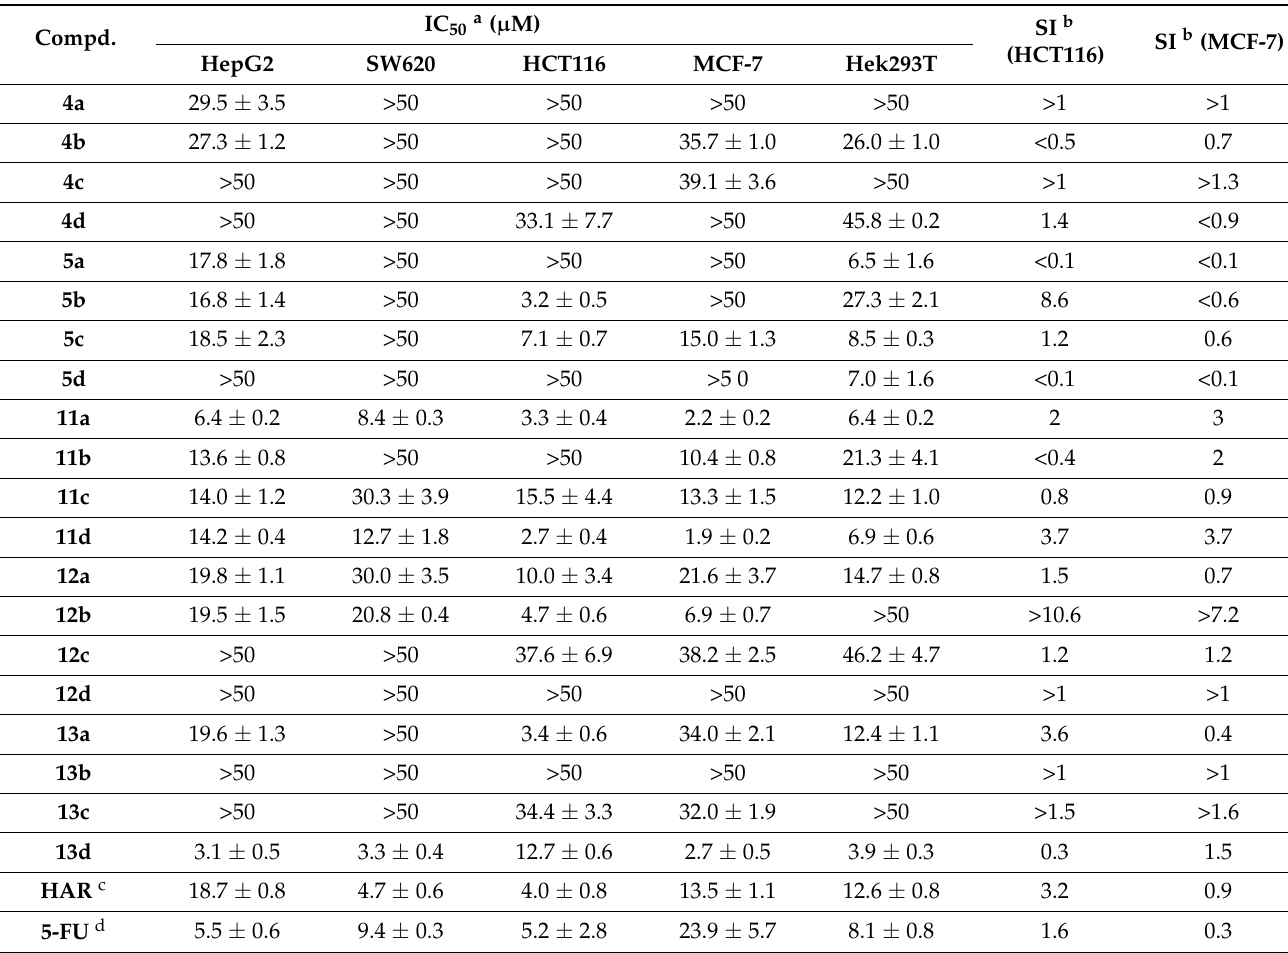
Table 2. In vitro cytostatic activity of harmirins 4 , 5 , and 11 – 13 against human cell lines and calculated selectivity indices.